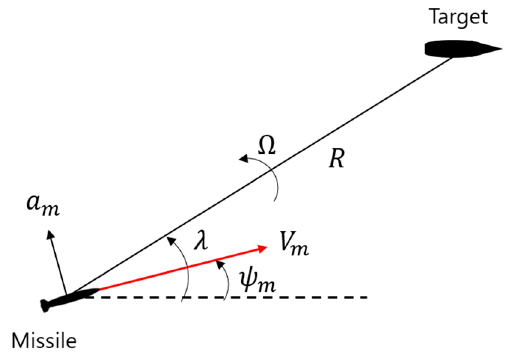
Figure 1. Two-dimensional engagement geometry.